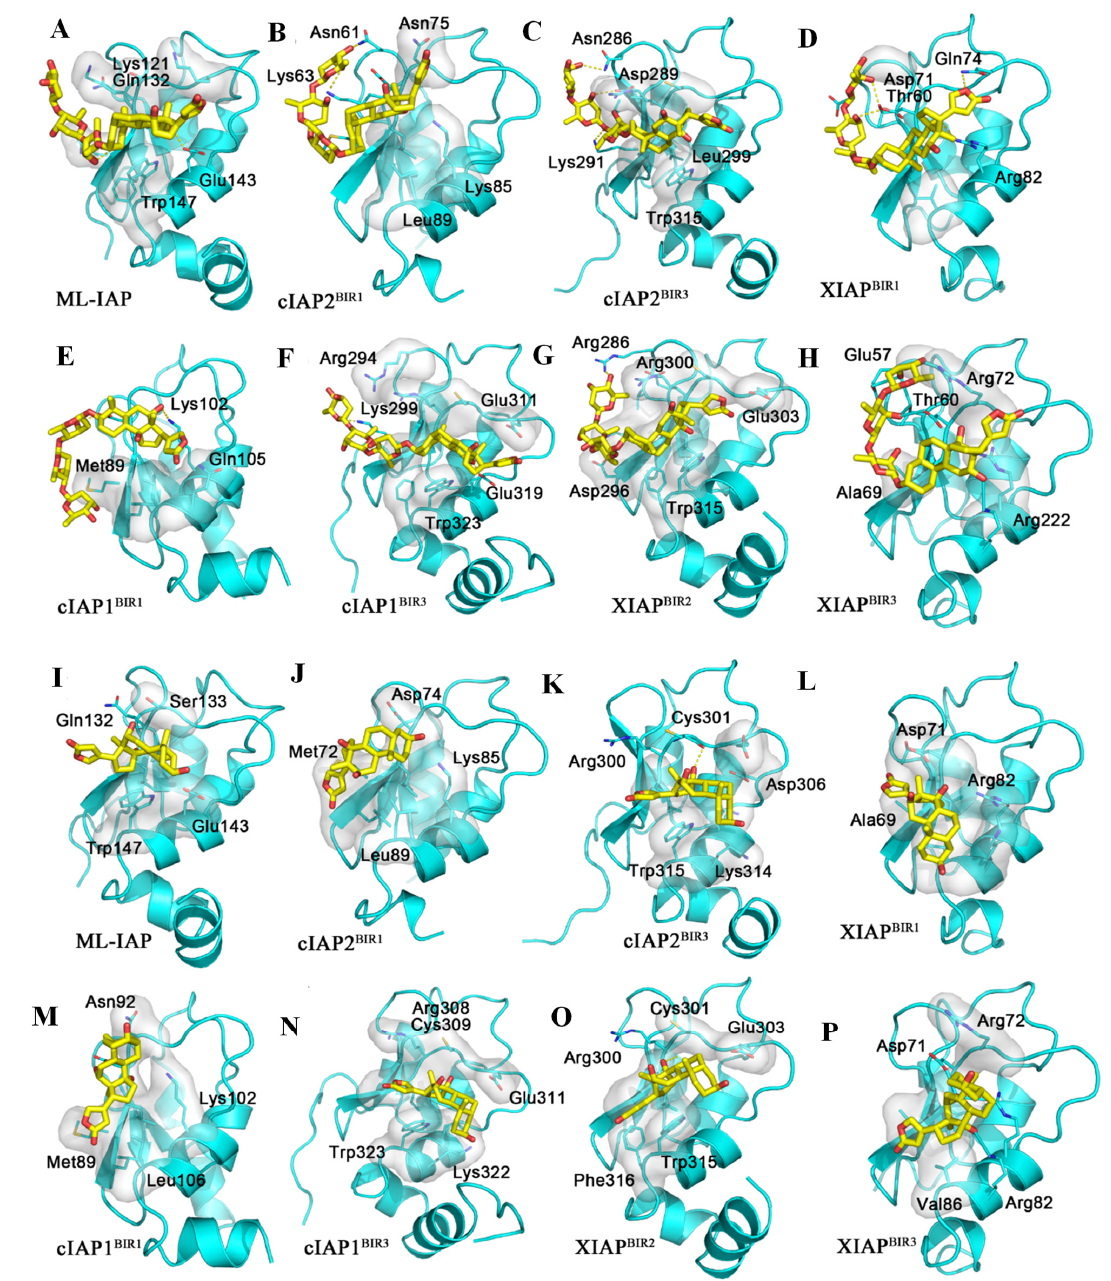
Figure 6. Docking profiles for digoxin or digoxigenin and inhibitor of apoptosis (IAP). The IAP family includes X chromosome-linked IAP (XIAP), cellular IAP-1 (cIAP1), cellular IAP-2 (cIAP2), and melanoma IAP (ML-IAP). The active domains of the IAP proteins are the baculoviral IAP repeat (BIR) domains, and most of these proteins have more than one BIR domain, for which the sequence alignment was generated by Clustal X, and sequences and structures of the active sites of the BIR domains are notably similar. A total of eight BIR domain structures were obtained from the PDB database, belonging to different IAP proteins, to which digoxin and digoxigenin were docked by Autodock Vina. Shown above are the docking profiles for digoxin (yellow) and ML-IAP ( A ), cIAP2 BIR1 ( B ), cIAP2 BIR3 ( C ), XIAP BIR1 ( D ), cIAP1 BIR1 ( E ), cIAP1 BIR3 ( F ), XIAP BIR2 ( G ), and XIAP BIR3 ( H ); and digoxigenin (yellow) and ML-IAP ( I ), cIAP2 BIR1 ( J ), cIAP2 BIR3 ( K ), XIAP BIR1 ( L ), cIAP1 BIR1 ( M ), cIAP1 BIR3 ( N ), XIAP BIR2 ( O ), and XIAP BIR3 ( P ). When using 4KMN as the receptor, digoxin and digoxigenin (yellow) lie on the surface of the binding site, and the steroid motif fits into one of the grooves. The hydrophobic residues at the bottom of the pocket of IAPs may provide some beneficial interactions of these two compounds. However, their overall conformation limits the interaction with the other groove, and the lack of any hydrogen bond interactions makes the bonding between these compounds and IAPs very weak ( A – P ). Thus, both compounds do not bind to IAPs